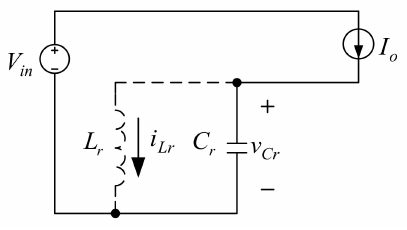
Figure 8. Equivalent circuit in state